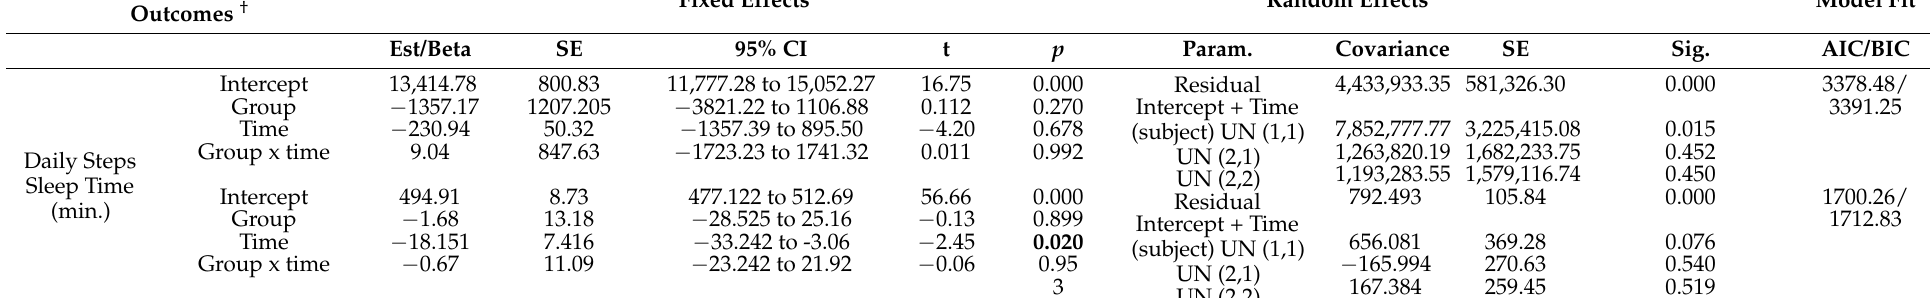
Main Effects Group